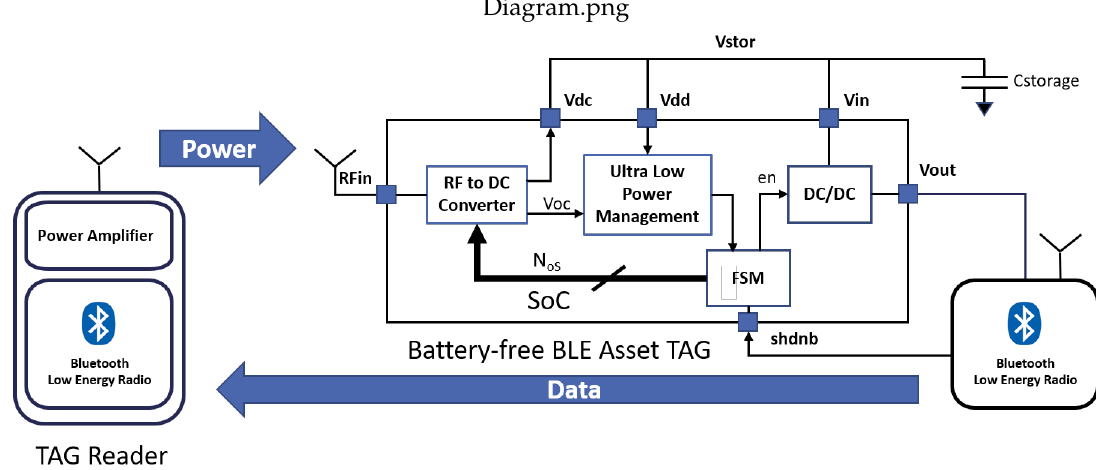
Figure 1. RF wireless power transfer